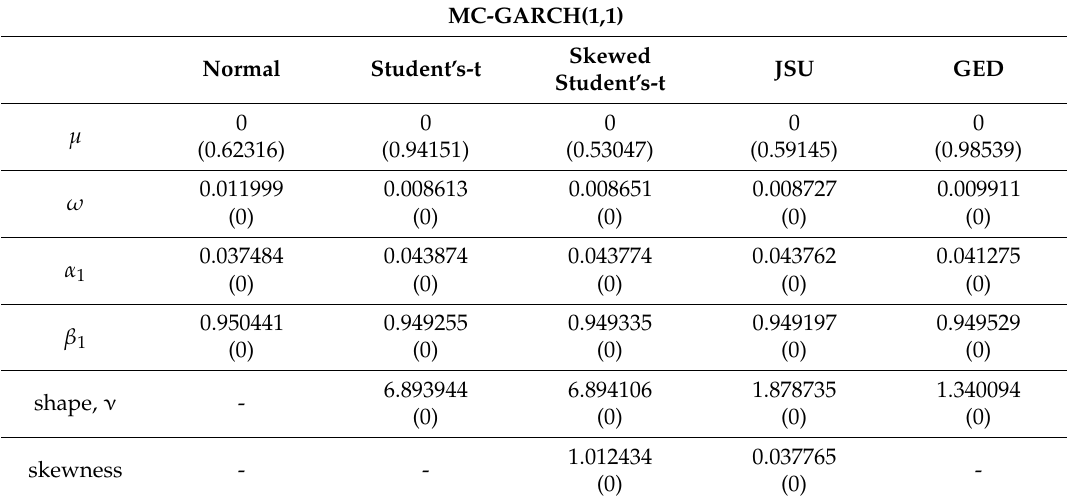
Table 3. MC-GARCH(1,1) parameter